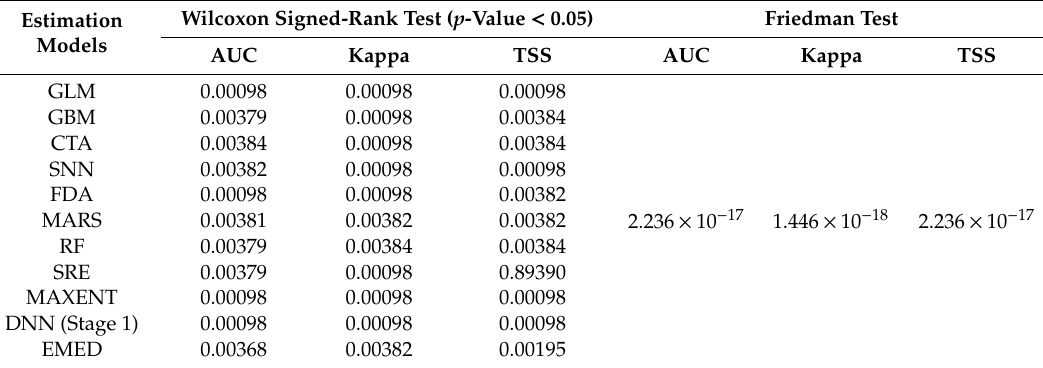
Table 8. The results of the Wilcoxon signed-rank and Friedman tests for our proposed